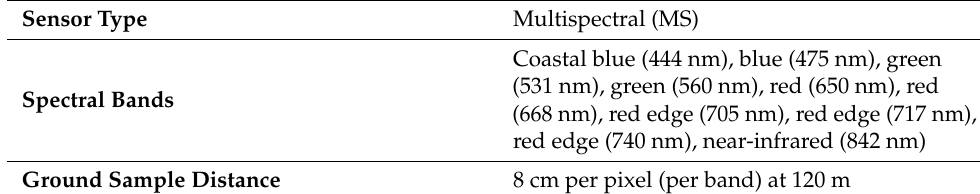
Table 1. MicaSense RedEdge-MX Dual MS